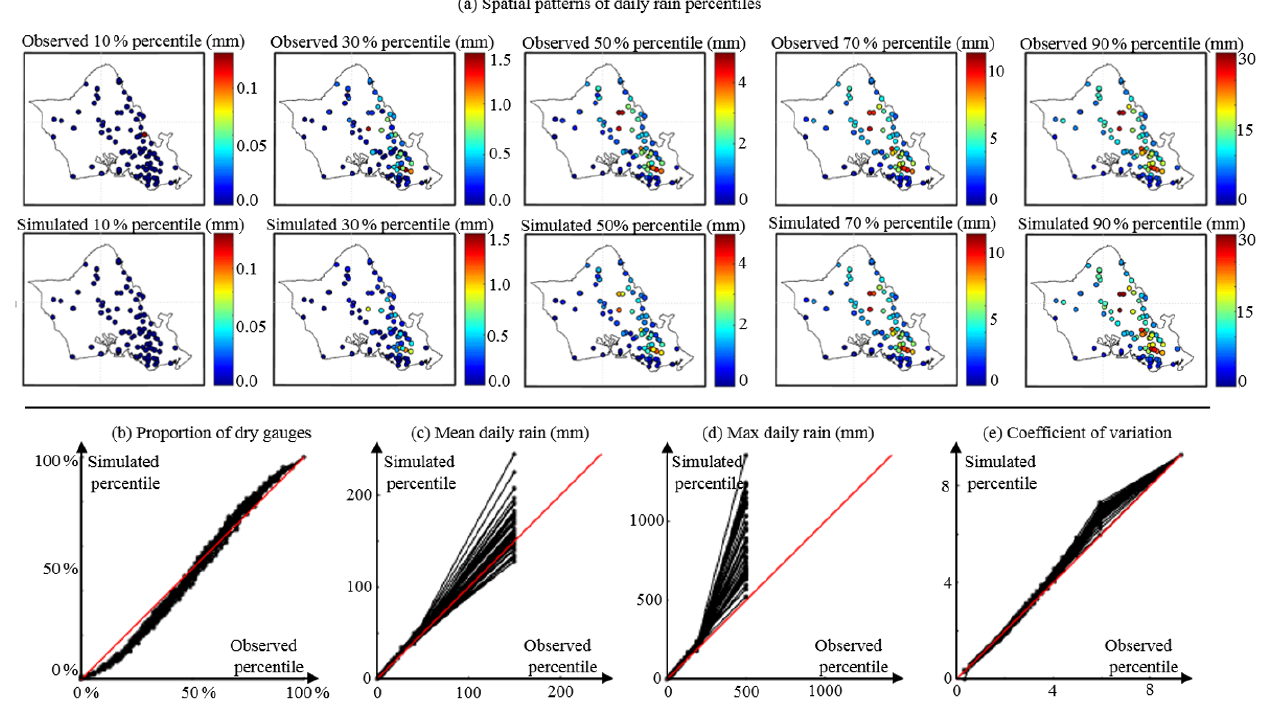
Figure 6. Assessment of island-scale statistics simulation in O‘ahu. (a) Spatial patterns of observed (upper row) and simulated (lower row) percentiles of daily rain accumulation. From left to right: 10, 30, 50, 70, and 90% percentiles. (b–d) The q–q plots of key rain statistics aggregated over the whole rain gauge network: (b) proportion of dry gauges; (c, d) mean and max daily rain; (e) coefficient of variation. Corresponding pdfs are displayed in Sect. S3. In panels (b–e) we display q–q plots between one observation time series (abscissa) and 50 simulations (ordinates). Hence, black dots line up vertically in the q–q plots because for each percentile, 50 simulations are compared to a single observation. To distinguish between simulations, quantiles related to the same simulation are connected by a solid black